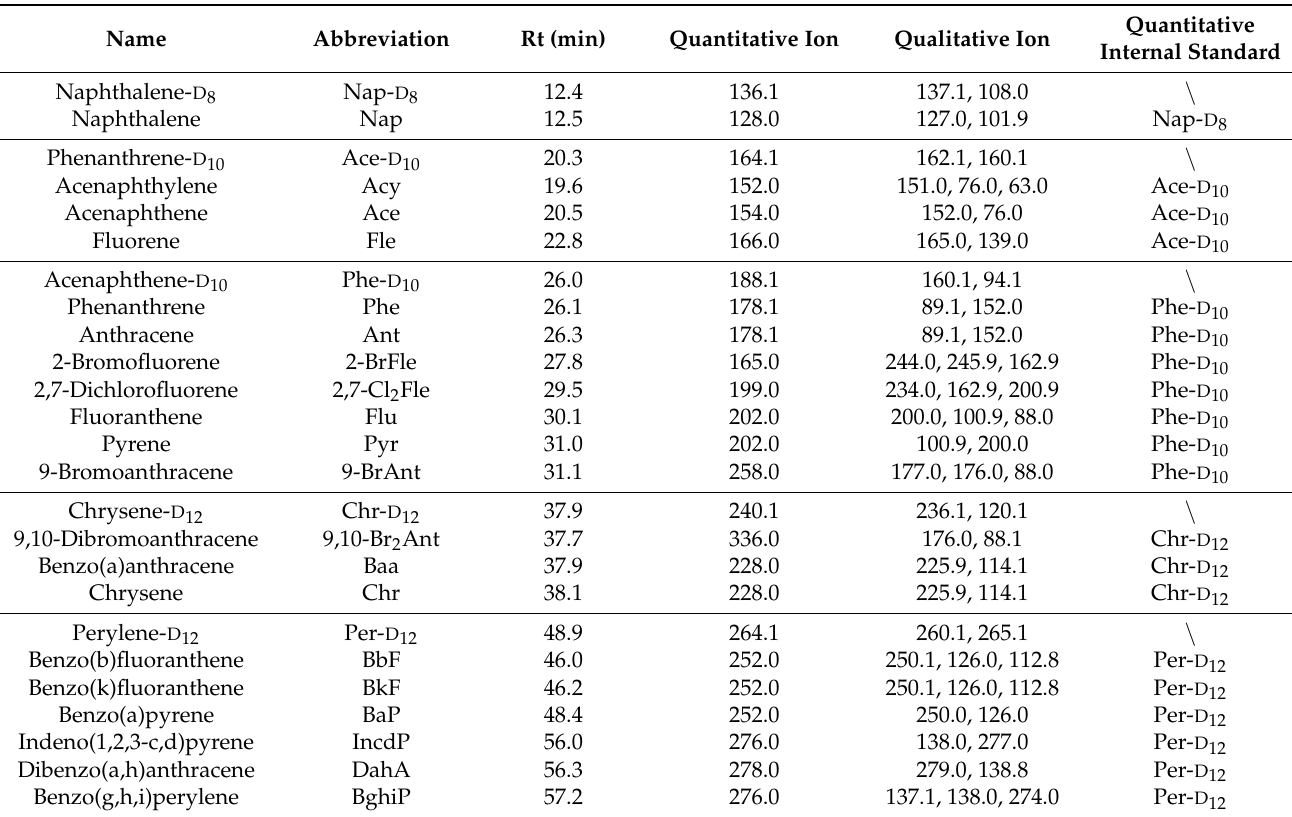
Table 1. The retention time (Rt), quantitative ion and qualitative ion of each